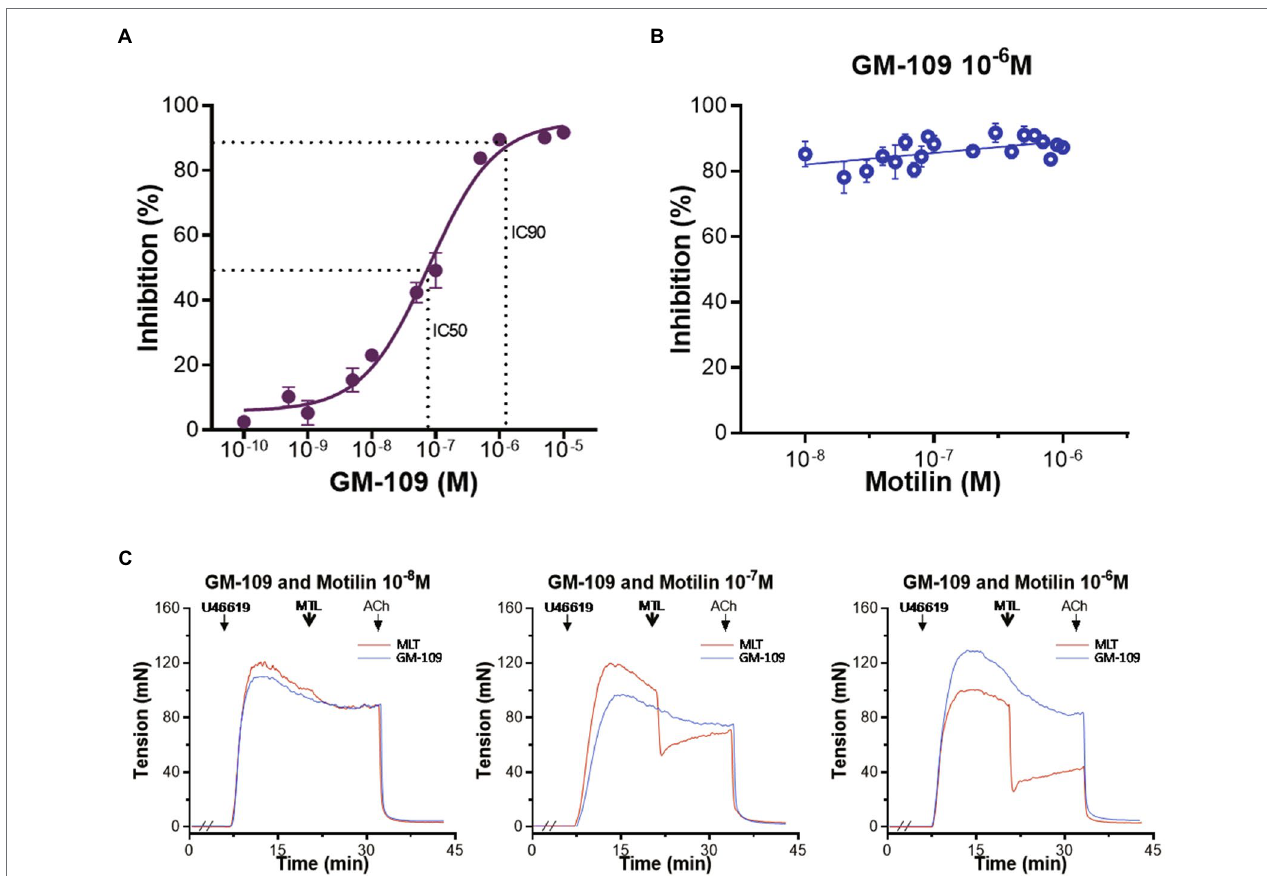
induced vasorelaxation.